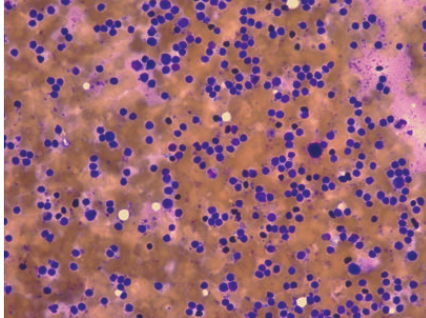
Figure 1: Fine needle aspirate (FNA) of lymph node from left neck. Diagnosis negative for malignancy. Favor reactive lymph